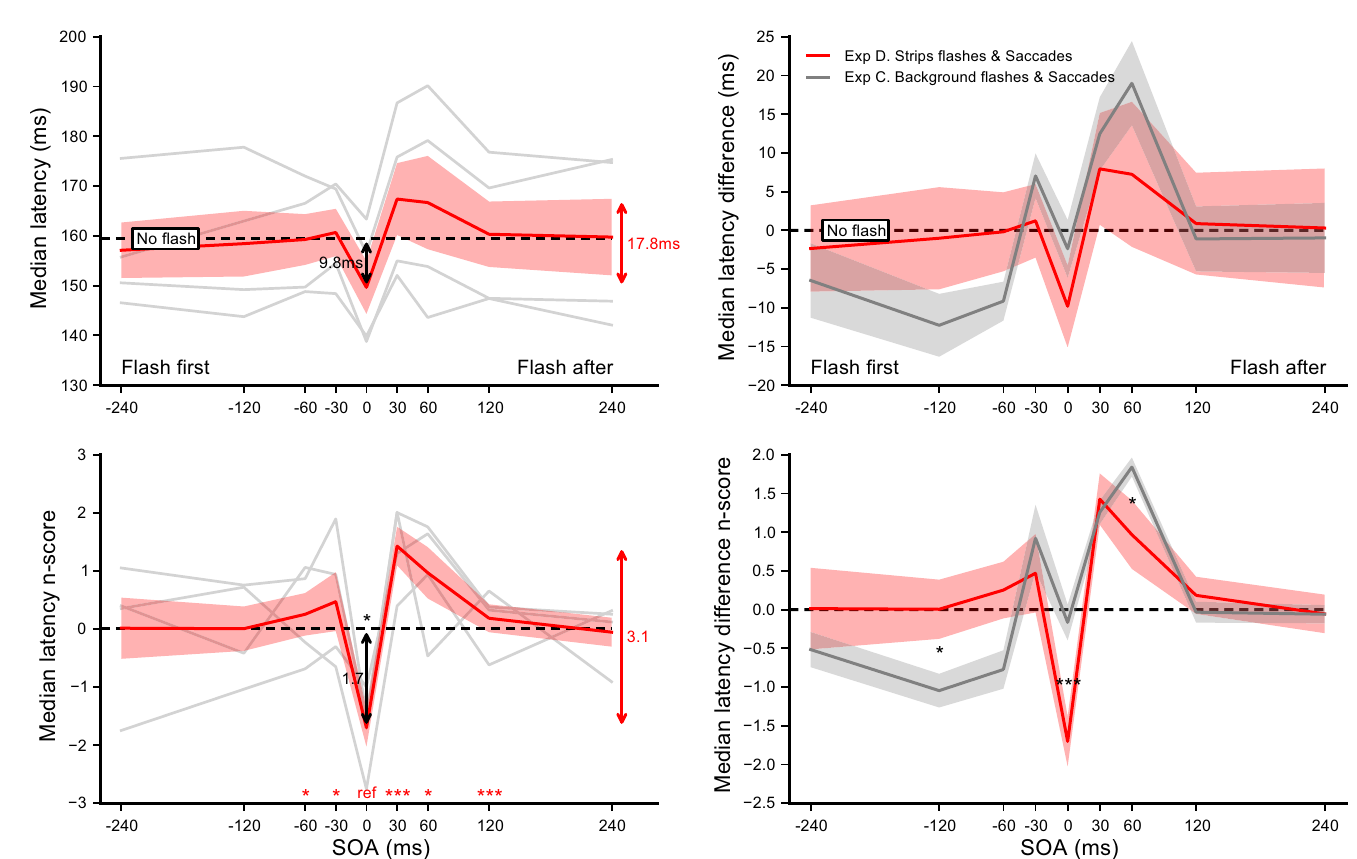
Fig 5. Experiment D. Effect of strips flashes on saccade onset (left panel). Median latencies averaged across participants for each SOA condition (top) and the corresponding n scores (bottom). Dashed lines show the No flash condition level and grey lines show individual results. Error bars indicate inter-individual SEM. Statistics included a single sample t-test performed on the n scores of the SOA = 0 ms reference condition to highlight the difference with the No flash condition (black arrow), and paired t-tests comparing this reference with each of the other SOA condition (red stars for each SOA above the X-axis). Background flashes vs. strips flashes (right panel). Comparison between experiment D (red plot) and C (grey plot): median latency differences (top) and n score differences (bottom) aligned on the No flash condition (dashed lines). Statistics were unpaired t-tests performed on the n score differences between experiments for each of the 9 SOA conditions. Three stars indicate highly significant differences after Bonferroni correction (p < 0.00555) while single stars significant differences without correction (p < 0.05). Red arrows indicate the overall range of